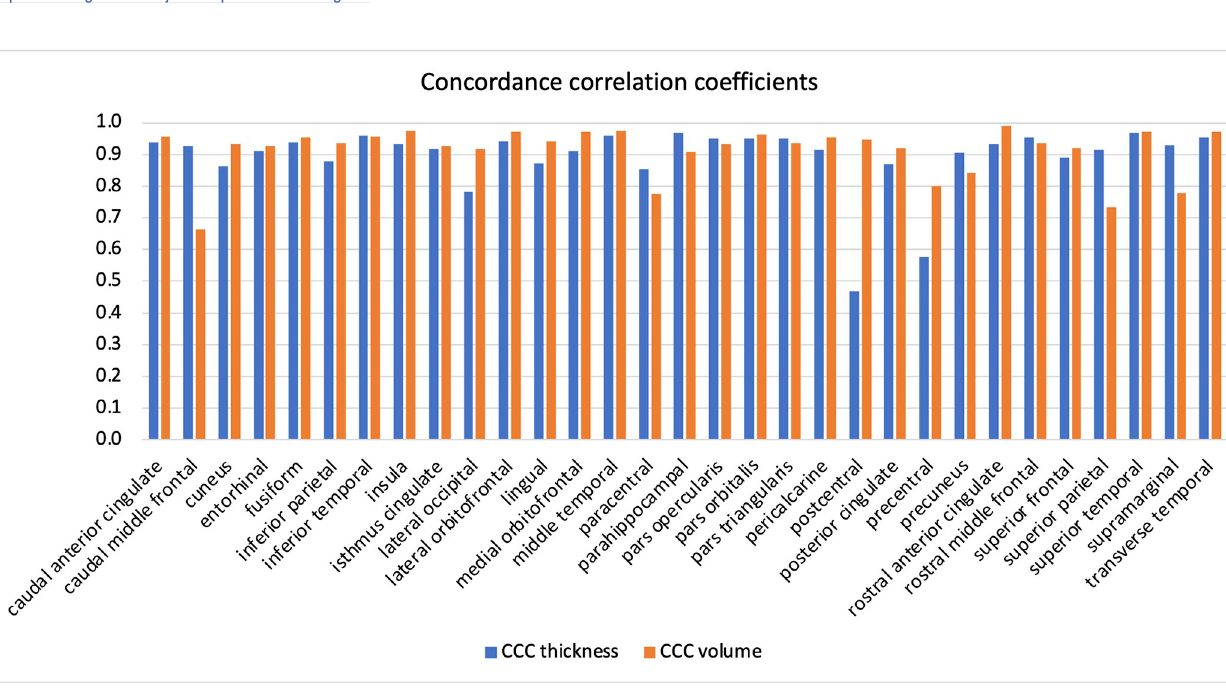
PLOS ONE | https://doi.org/10.1371/journal.pone.0284440 April 14, 2023 7 /